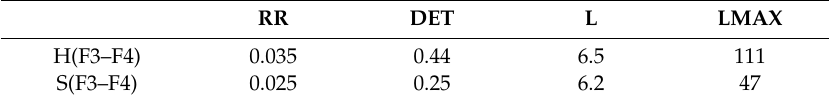
Table 1. CRQA measures for both selected example electrodes with same ε =